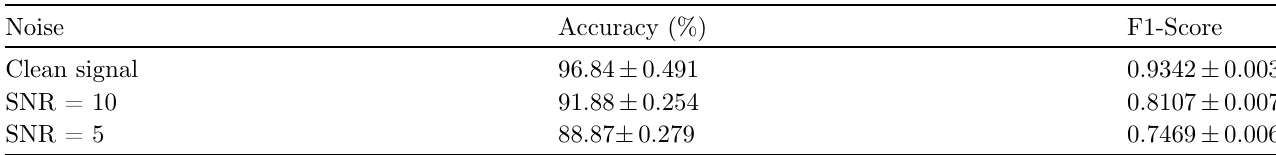
Table 3. Classi fi cation of perturbation type in the time domain under differing levels of input signal noise corruption from individual detector